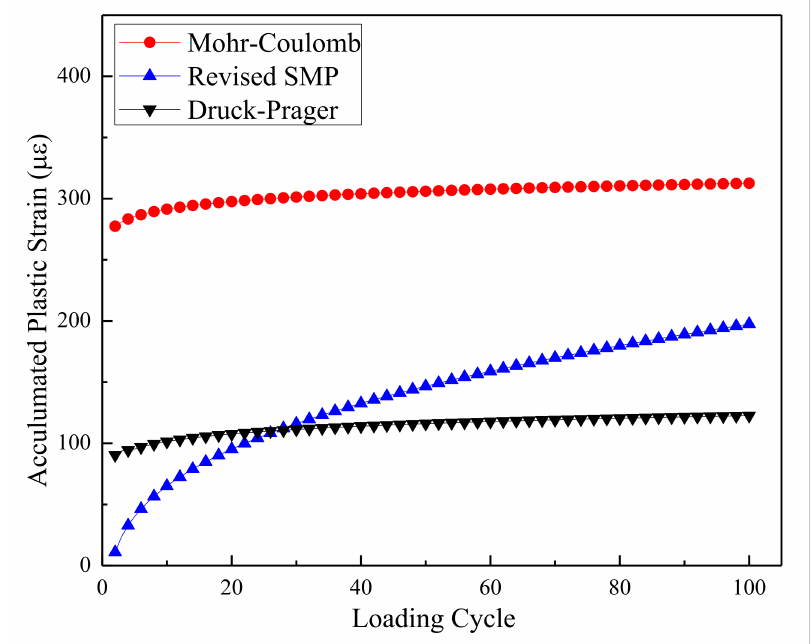
Figure 8. Relationship of average vertical plastic strain and loading cycle using the three models.